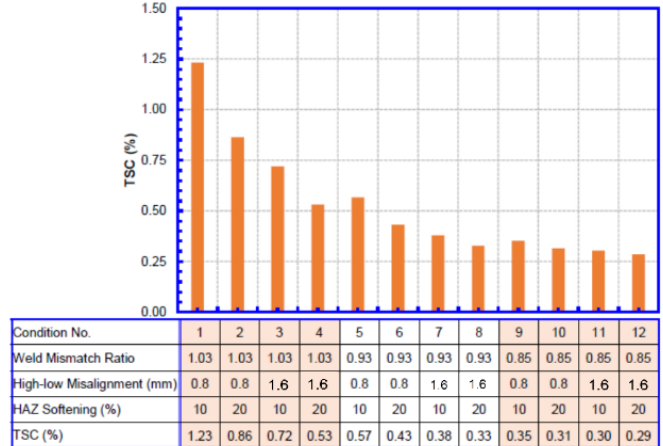
Figure 8. TSC of girth welds with 18.4 mm + 18.4 mm WT.